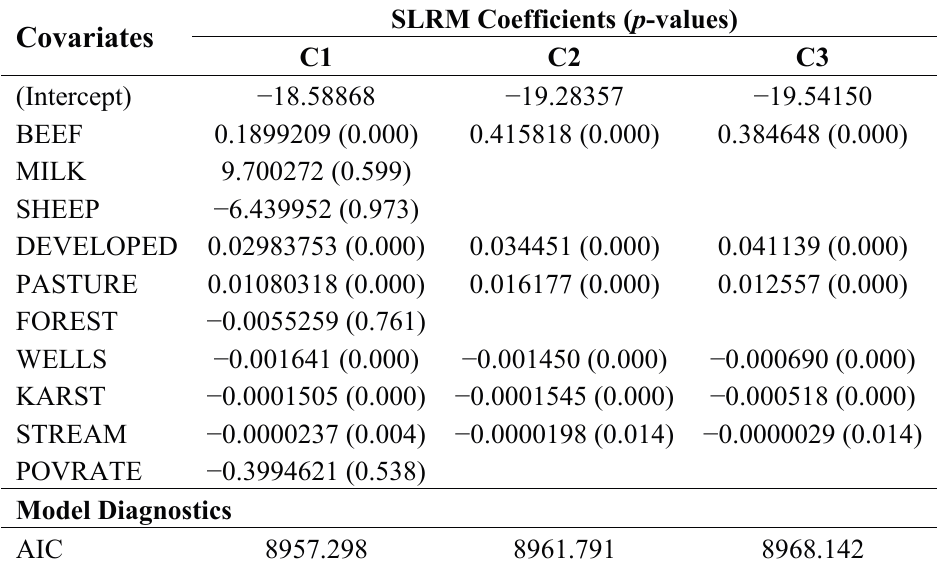
Table 2. Spatial logistic regression model (SLRM) coefficients ( p -values in parentheses) for cryptosporidiosis individual models. Shaded cells represent excluded variables. Model diagnostics (AIC) are shown on the bottom row.